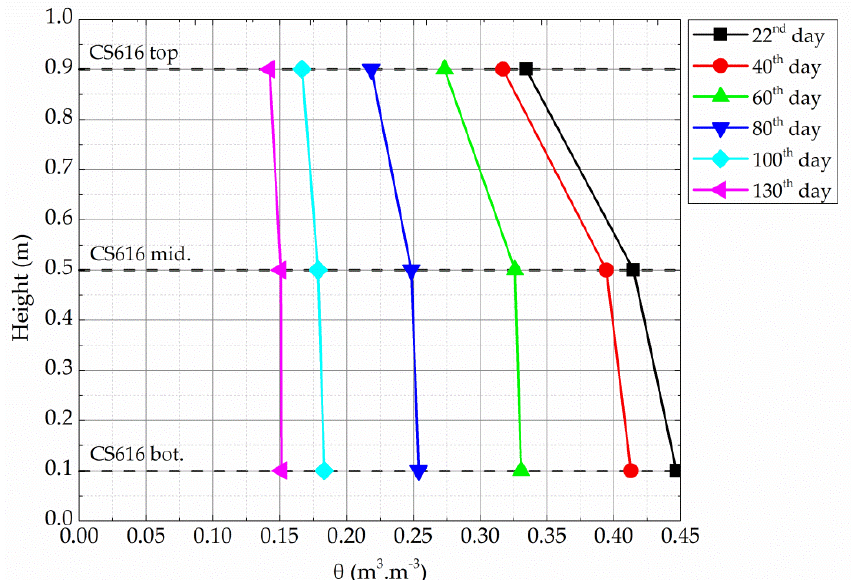
Figure 7. Volumetric water content depending on the height in the